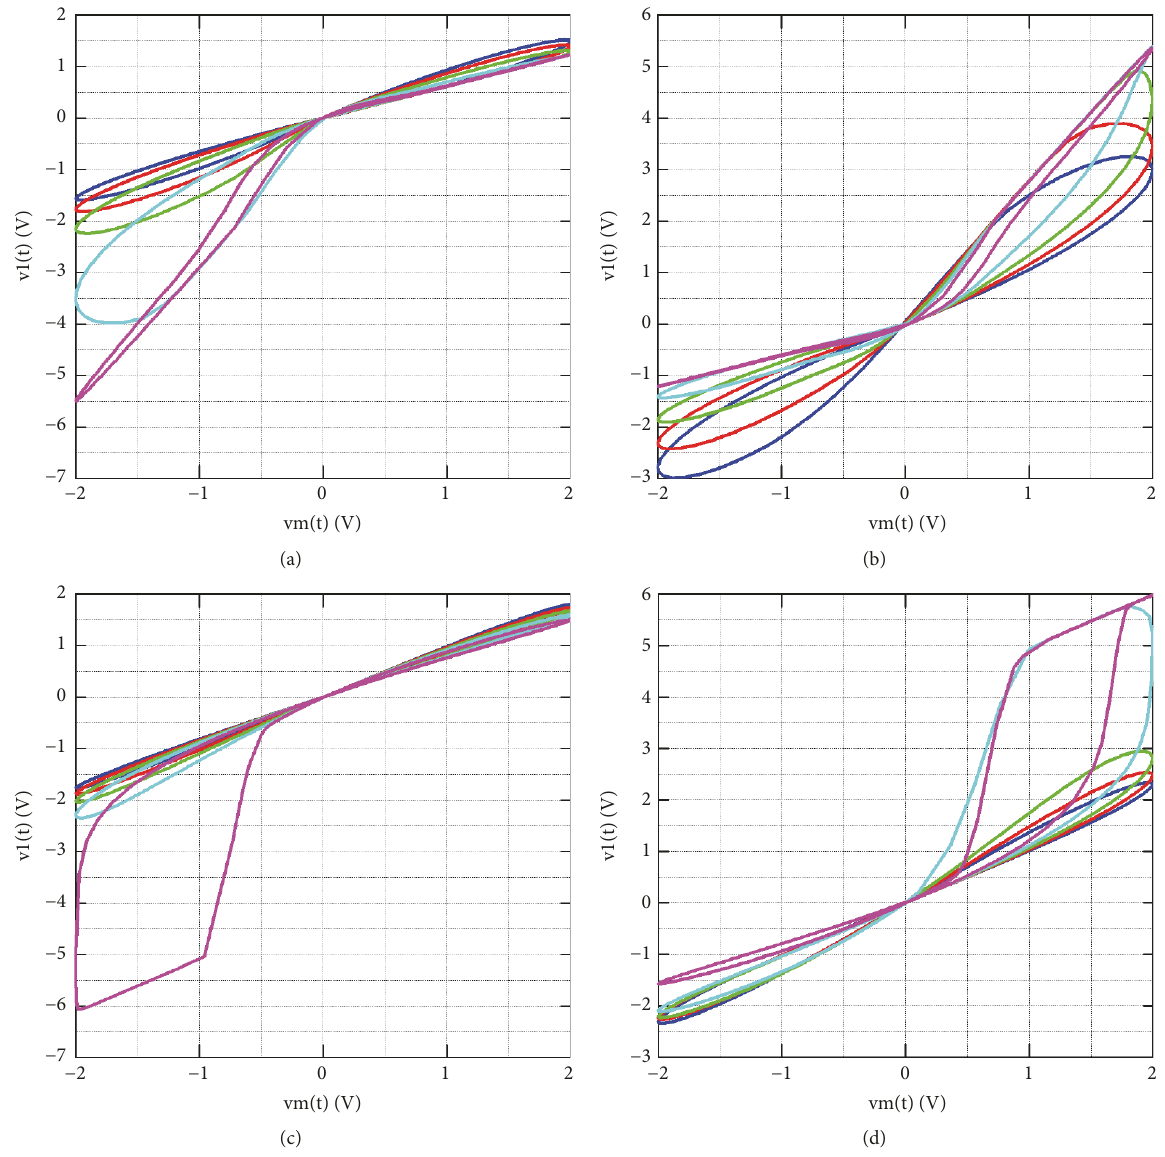
Figure 6: Fractional-order frequency-dependent pinched hysteresis loops of the floating fracmemristor operating at (a) incremental mode and (b) decremental mode. For the grounded fracmemristor operating at (c) incremental mode and (d) decremental mode. For all cases: 𝛼 = 0.99 (light blue line), 𝛼 = 0.75 (light red line), 𝛼 = 0.5 (light green line), 𝛼 = 0.25 (light cyan line), and 𝛼 = 1m (light magenta